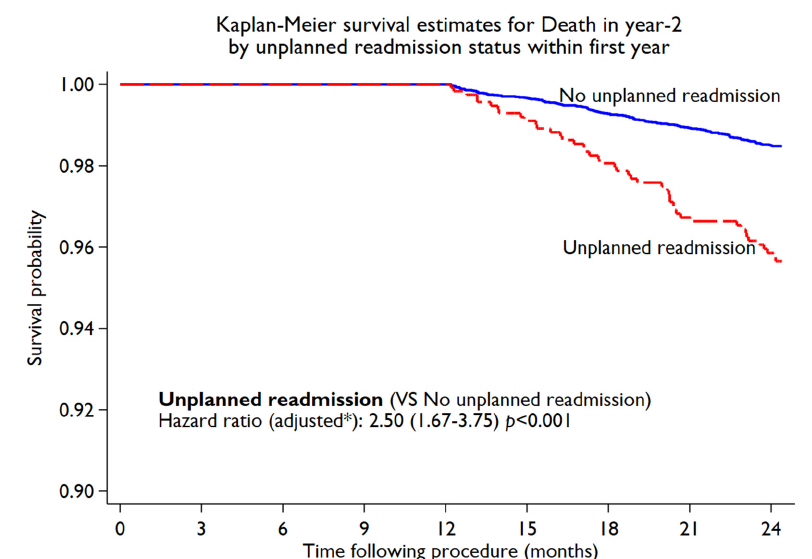
Figure 2. Kaplan–Meier curve for unplanned cardiac readmissions within first year following PCI by sex . * Adjusted for age, diabetes, BMI, hypertension, hypercholesterolemia, previous history of MI, PVD, or CABG, smoking, renal dysfunction, pci presentation, and multivessel disease.